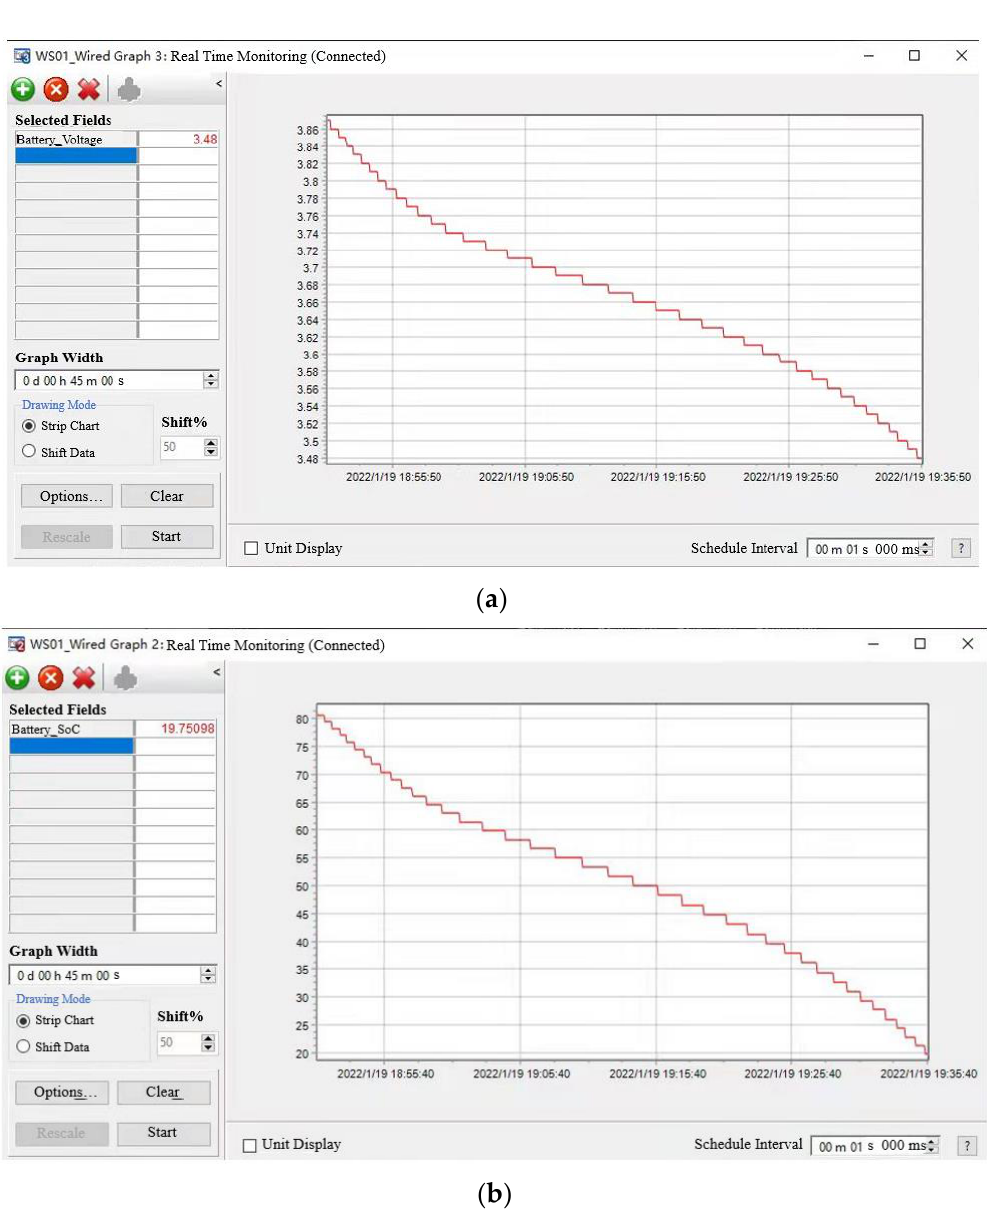
Figure 7. Real-time battery information demonstration: ( a ) real-time battery output voltage; and ( b ) real-time battery SoC.